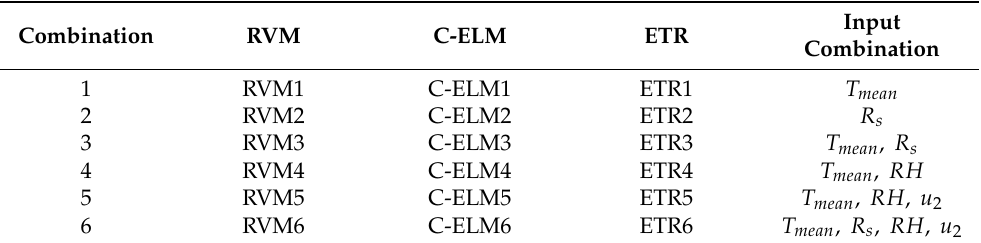
Table 2. Summary of the six input combinations of the meteorological parameters used in the RVM, C-ELM, and ETR